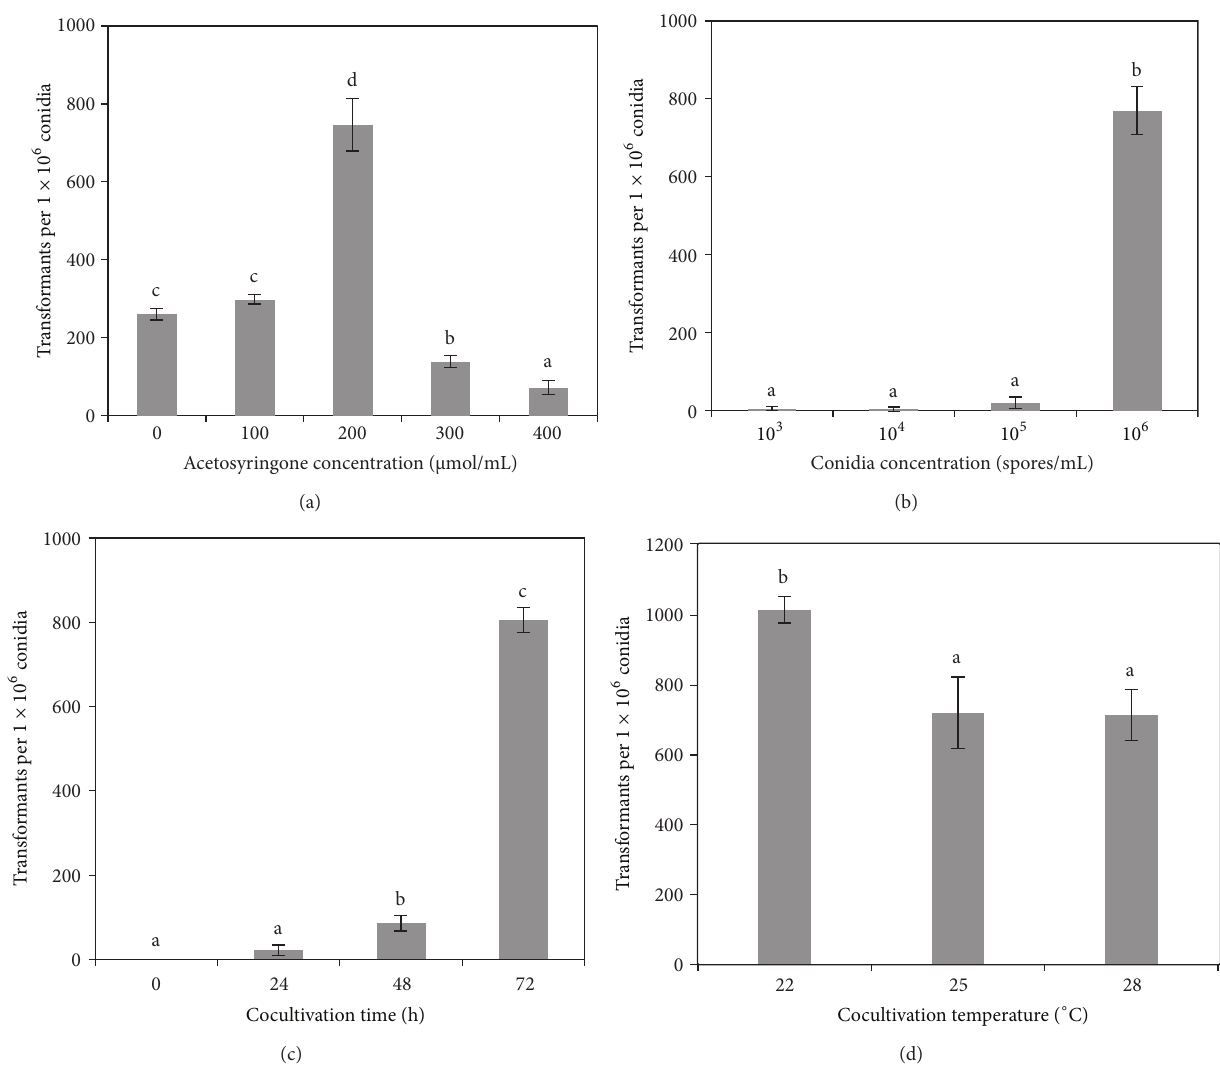
Figure 2: The effects of acetosyringone concentration (a), conidia concentration (b), co-cultivation time (c), and co-cultivation temperature (d) on the transformation efficiency of Valsa mali strain LXS240101. These four factors exhibit obvious impacts on the transformation efficiency. Data are the mean ± SD of triplicate experiments. Different letters on the bar in the same histogram show statistical significance ( 𝑃 < 0.05 ) on the transformation